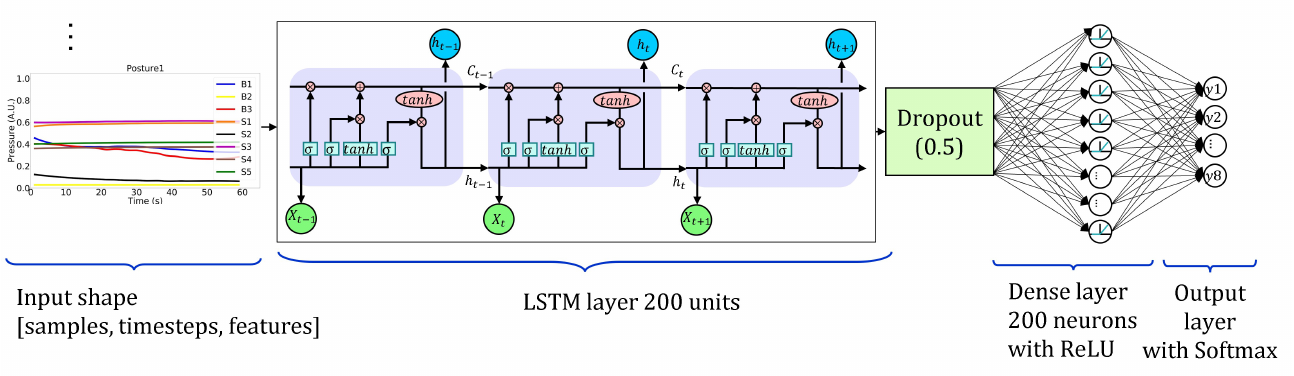
Figure 8. The adopted LSTM model architecture. Input has a 3D shape, hidden layers are LSTM with 200 units, dropout, and a dense layer with 200 neurons. The output layer has 8 neurons for 8 posture